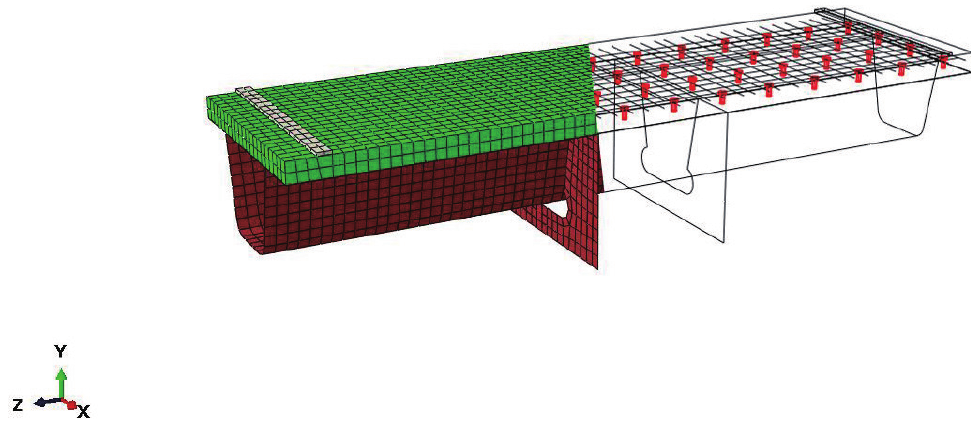
Figure 11. Meshing of composite beam finite element model and distribution of reinforcement frame and